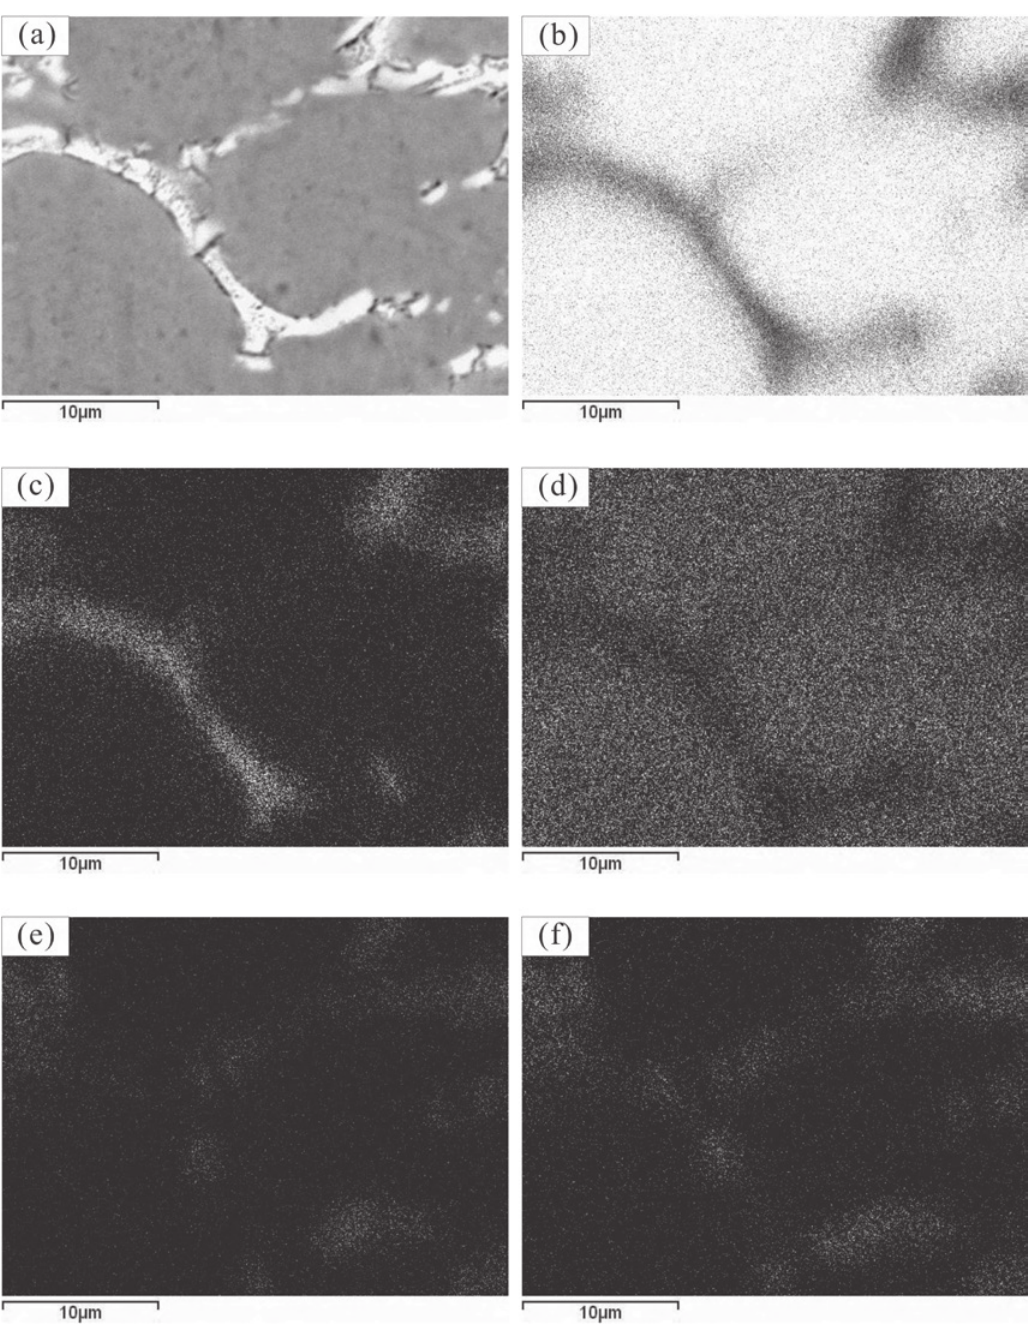
Fig. 2: The SEM microstructure of as-cast alloy 2618 and elements distribution: (a) SEM microstructure; (b) Al; (c) Cu; (d) Mg; (e) Fe; (f )